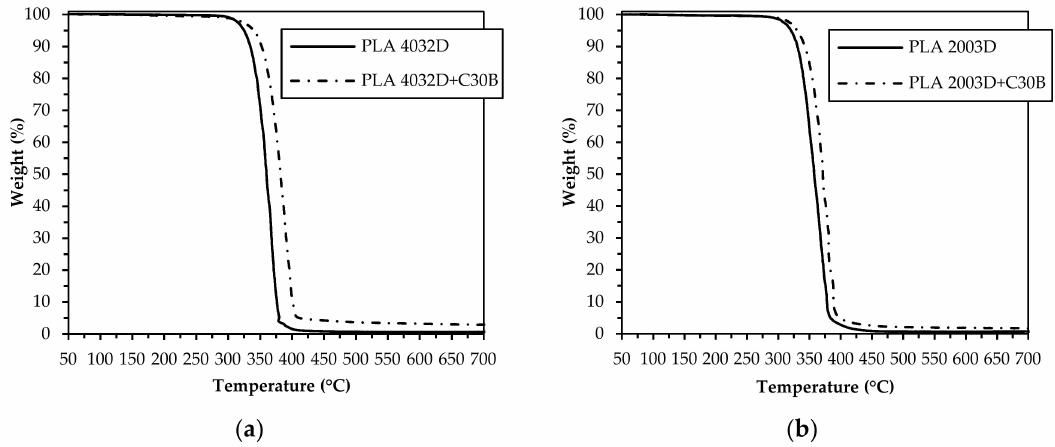
Figure 2. Weight loss of PLA 4032D and PLA 4032D+C30B ( a ) and PLA 2003D and PLA 2003D+C30B ( b ). Table 3. Temperatures corresponding to a weight loss of 25, 50, and 75% in respect to the initial weight.